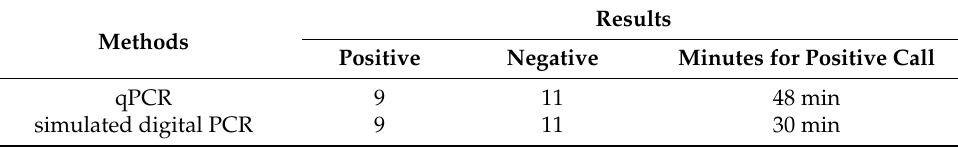
Table 4. Ct of qPCR products produced from different copies of standard plasmid